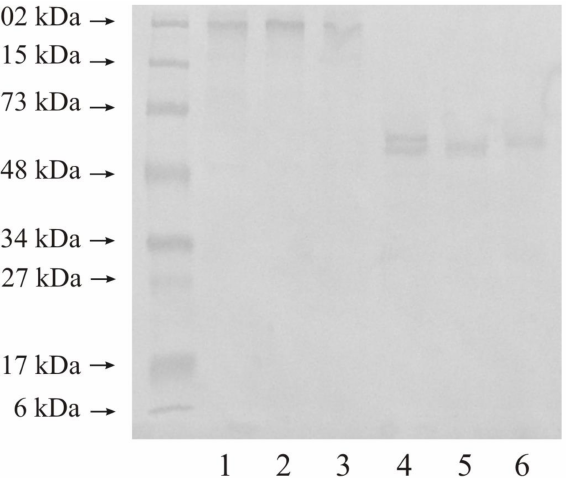
Figure 3. Western immunoblot of MMP-3 in control tissue and low-grade (LG) and high-grade (HG) urinary bladder cancer. Twenty micrograms of protein: lane 1—control urinary bladder, 2—low- grade bladder cancer, 3—high-grade bladder cancer; twenty microgram protein: lane 4—control urinary bladder, 5—low-grade bladder cancer, 6—high-grade bladder